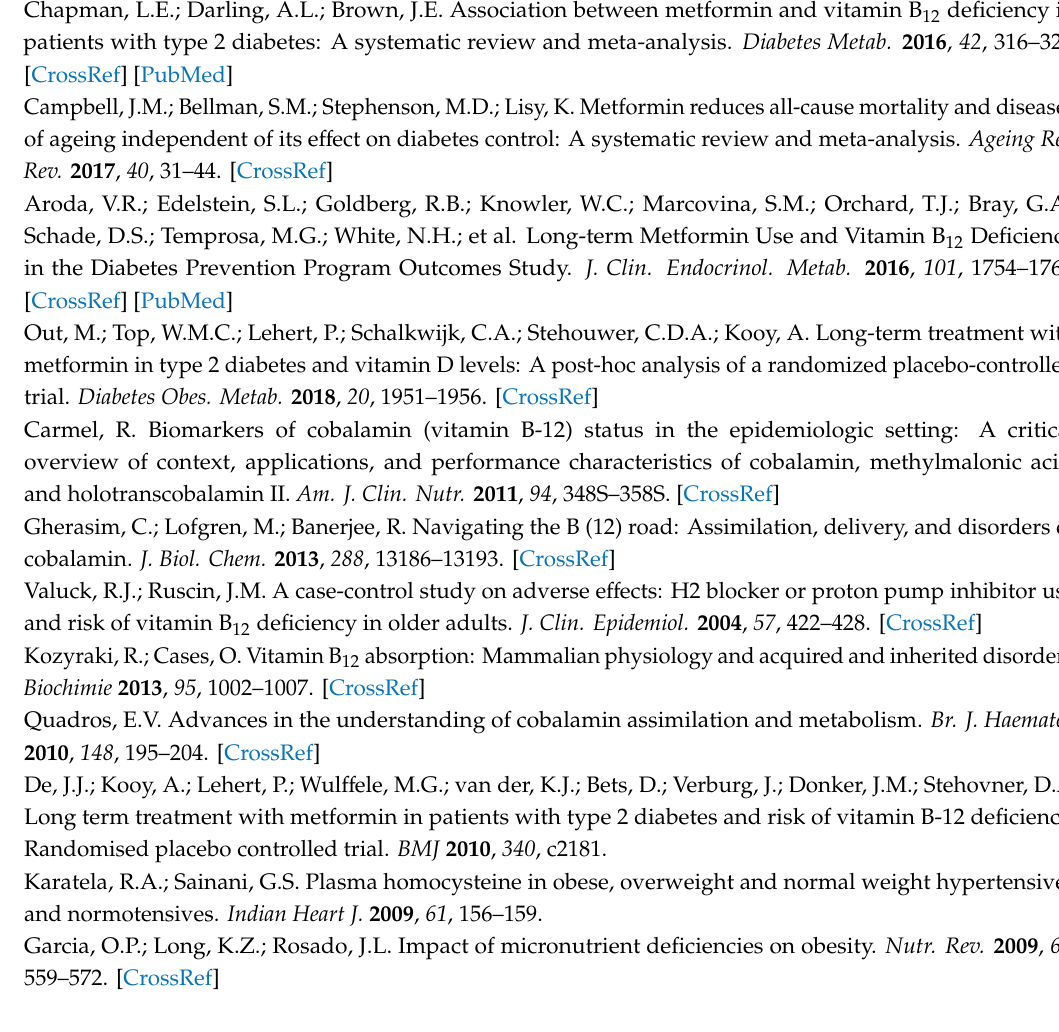
Table S1: Baseline anthropometric parameters, Table S2: Hematologic